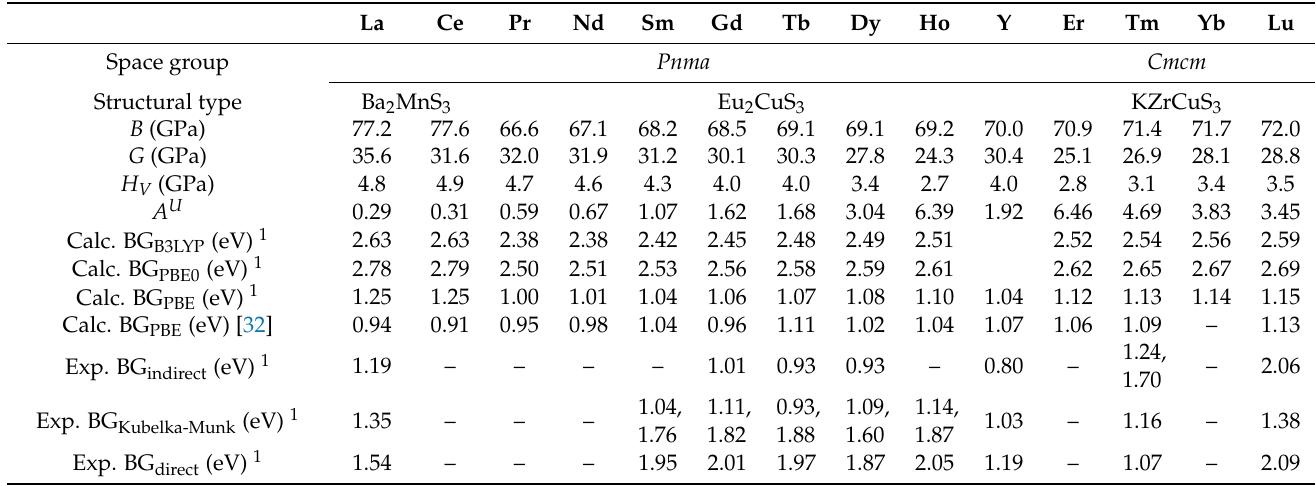
Table 2. Bulk modulus ( B ), shear modulus ( G ), Vickers hardness ( H V ), universal anisotropy index ( A U ), calculated (Calc.) and experimental (Ex.) values of the band gap (BG) for EuLnCuSe 3 (Ln = La,